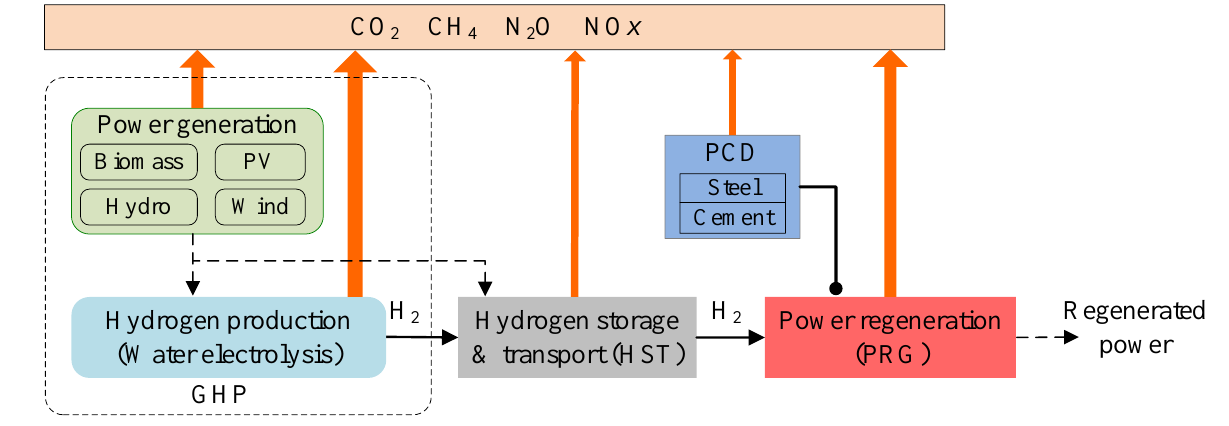
Figure 1. System boundaries and stages of the life cycle assessment of power regenerated by PHP + CCGT.